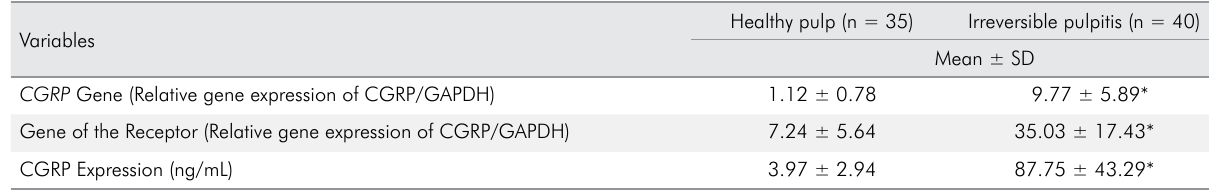
Healthy pulp (n = 35) Irreversible pulpitis (n = 40) Mean ± SD